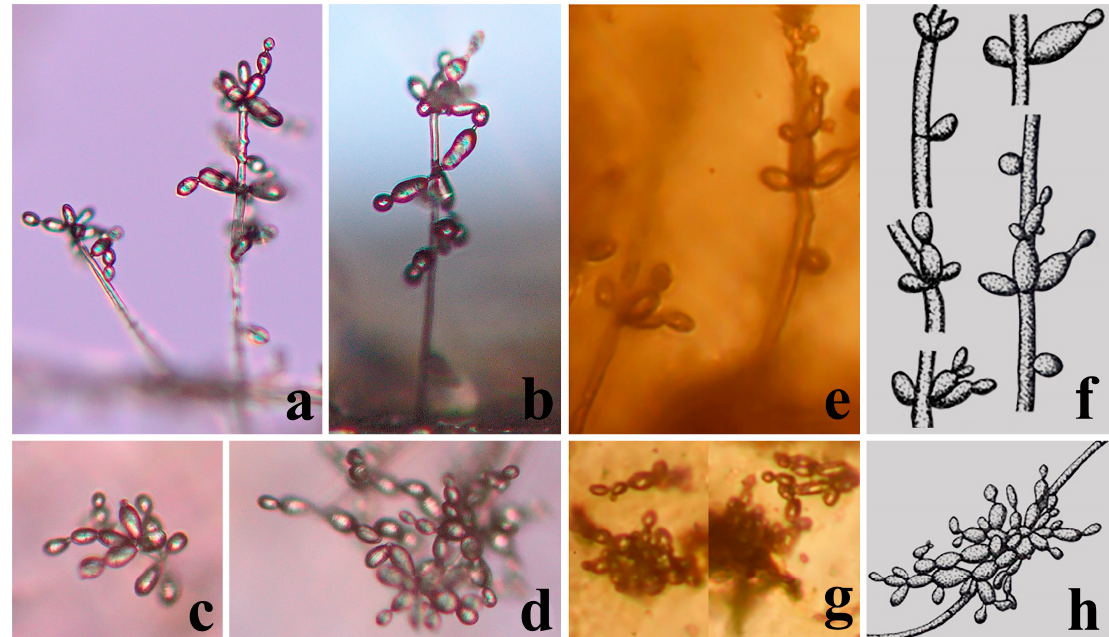
Figure 3. Blastospores and conidiophores of fossil and extant carnivorous fungi. ( a , b ) Conidiophores of Arthrobotrys blastospora ; ( c , d ) Blastospores of Arthrobotrys blastospora ; ( e , f ) Conidiophores of the fossil Palaeoanellus dimorphus ; ( g , h ) Blastospores of the fossil Palaeoanellus dimorphus, reprinted with permission from Ref. [24] 2023, John Wiley and Sons.